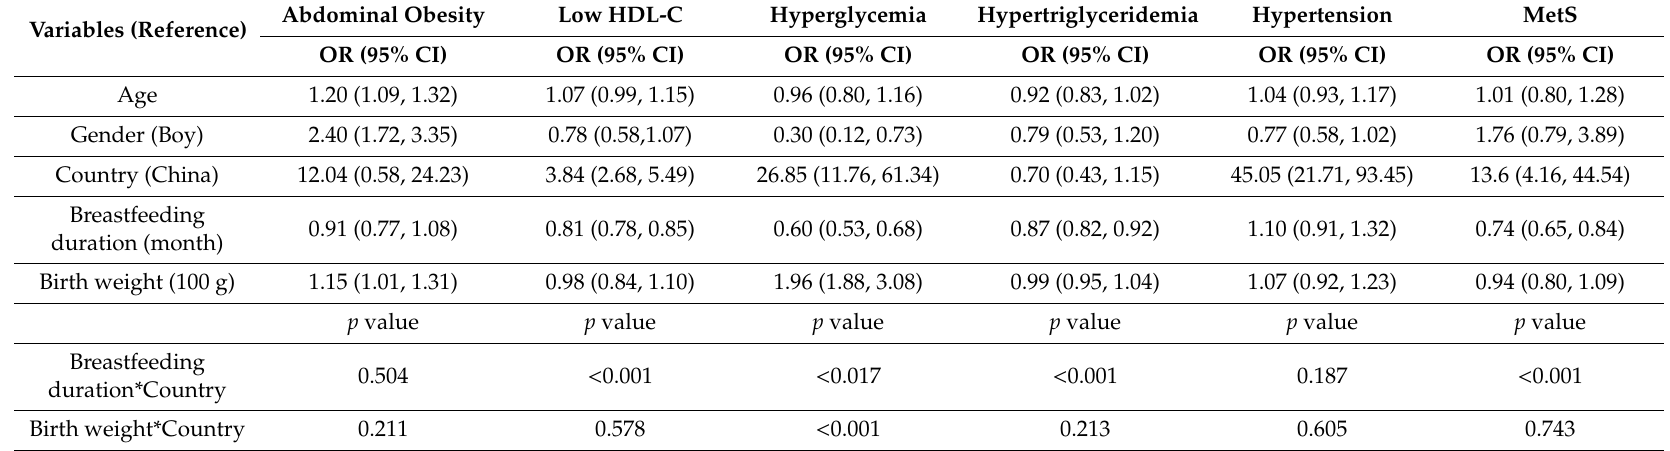
Table 5. Risk of MetS features based on associated factors from multivariable logistic